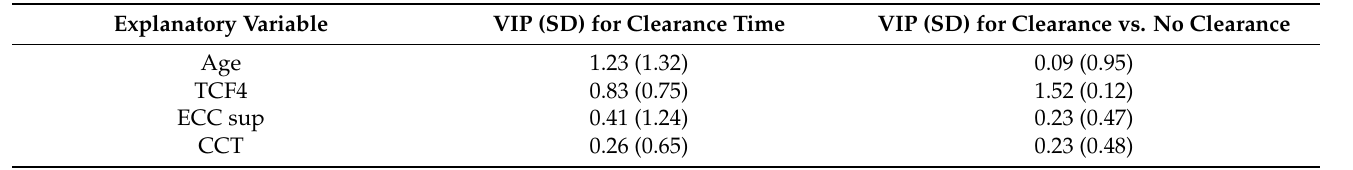
Table 2. Results of prediction models for corneal